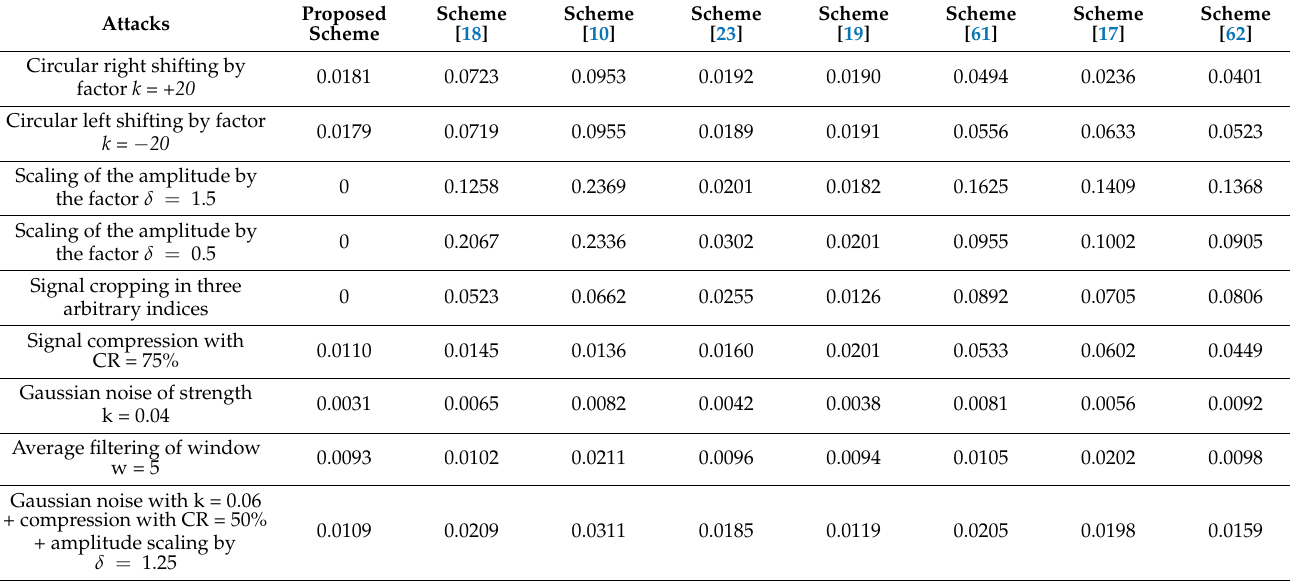
Table 4. Comparison of the average BER corresponding to the retrieved watermarks using various bio-signals zero-watermarking